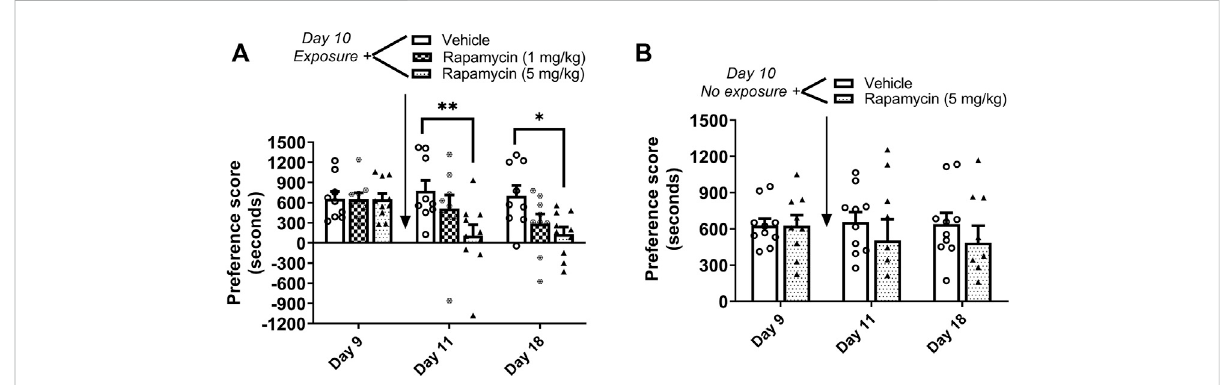
FIGURE 3 Rapamycin disrupts reconsolidation of cocaine memories. (A) Condition place preference was established with cocaine 10 mg/kg in three groups of mice as shown on day 9 during a 30-min post-conditioning test session. On day 10, mice were re-exposed to the cocaine-paired context in a drug-free state for 10 min to reactivate cocaine-associated memories. Rapamycin (1 or 5 mg/kg ip) or vehicle was administered immediately after exposure to the cocaine compartment. Mice were re-tested for cocaine place preference 24 h and 7 days later. Rapamycin (5 mg/kg) signi fi cantly abolished the previously established place preference when tested 24 h and 7 d after administration (days 11 and 18). Mice injected with vehicle maintained a signi fi cant cocaine place preference on days 11 and 18. (B) Condition place preference was established with cocaine 10 mg/kg in two groups of mice as shown on day 9. On day 10, mice remained in their home cages in the testing room and were injected with rapamycin (5 mg/kg ip) or vehicle. Mice were re-tested for cocaine place preference 24 h and 7 days later. Rapamycin administered in the home cage (ie, no exposure to the cocaine context) did affect the previously established cocaine place preference; both vehicle and rapamycin groups maintained a cocaine place preference when retested on days 11 and 18. * p < 0.05, ** p < 0.01 vs. vehicle, N = 9/group. Data are expressed as means ± SEM.